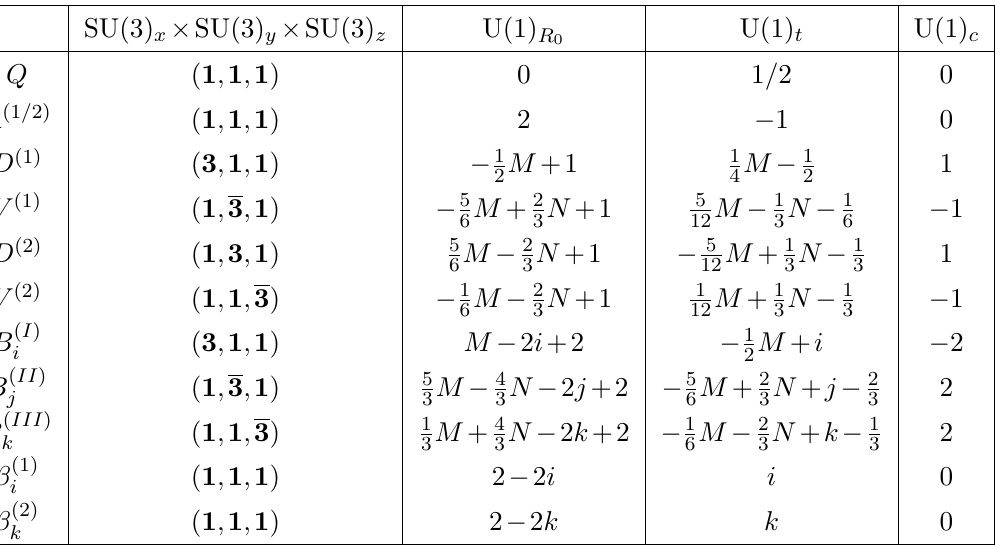
Table 5 . Charges and representations of the matter fields under the global symmetry, including the trial R -charge R 0